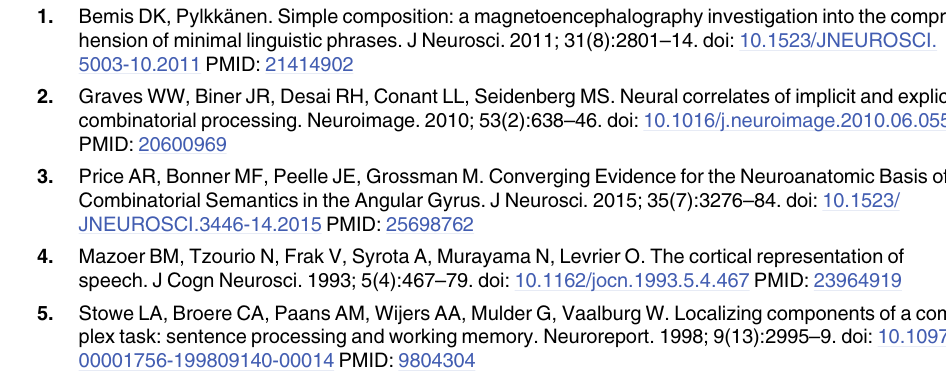
S2 Fig. ERP waveforms in the list task. The event-related potentials recorded at each electrode in the compose task. Voltage timeseries for the real word condition are plotted in blue, for the pseudoword condition in red, and for the nonword condition, in